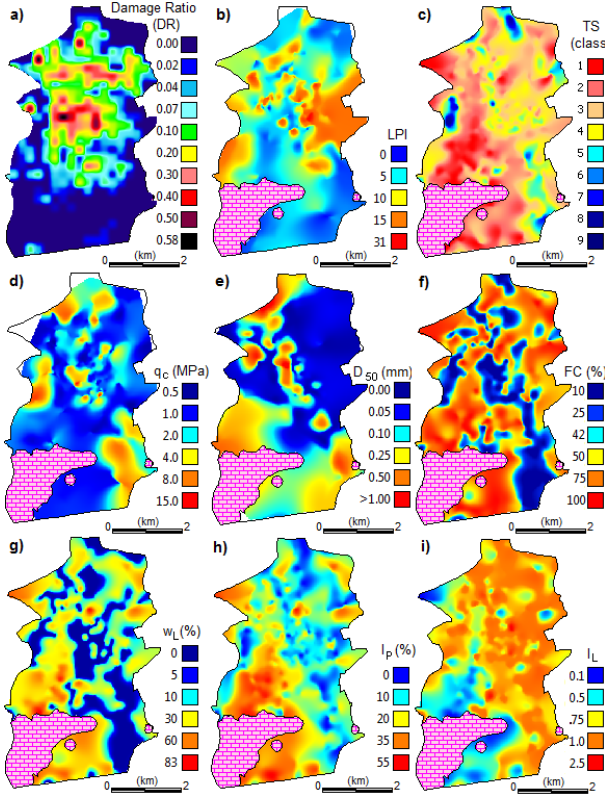
Fig. 3. Thematic maps used for establishing the NN model.